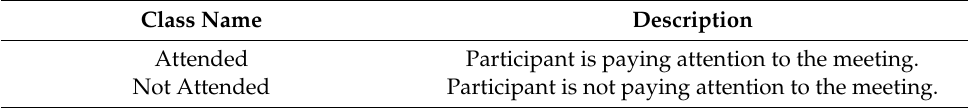
Table 2. Attention classes for image labeling.